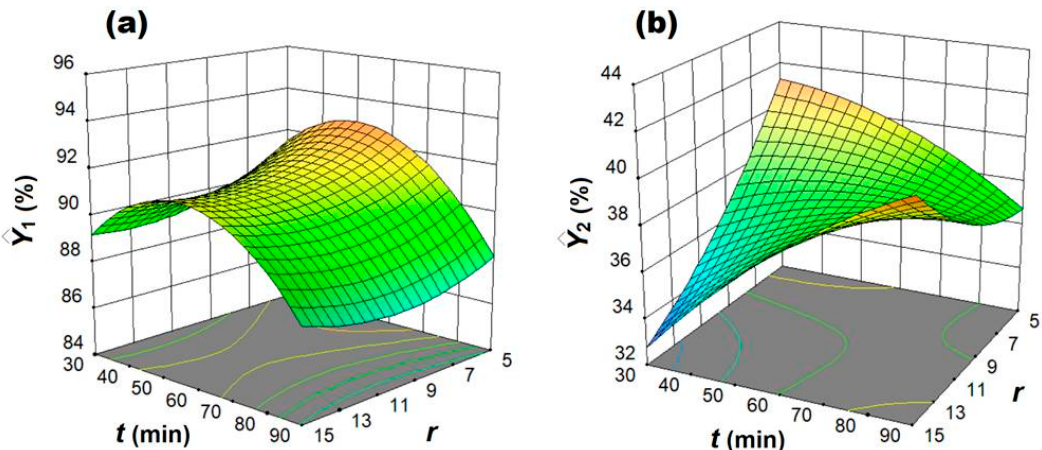
Figure 3. Surface plots of the responses derived from materials application in photodegradation: ( a ) removal efficiency of CR ( Y 1 ) depending on the factors ( t and r ); ( b ) removal efficiency of 2,4-D ( Y 2 ) depending on the factors ( t and r